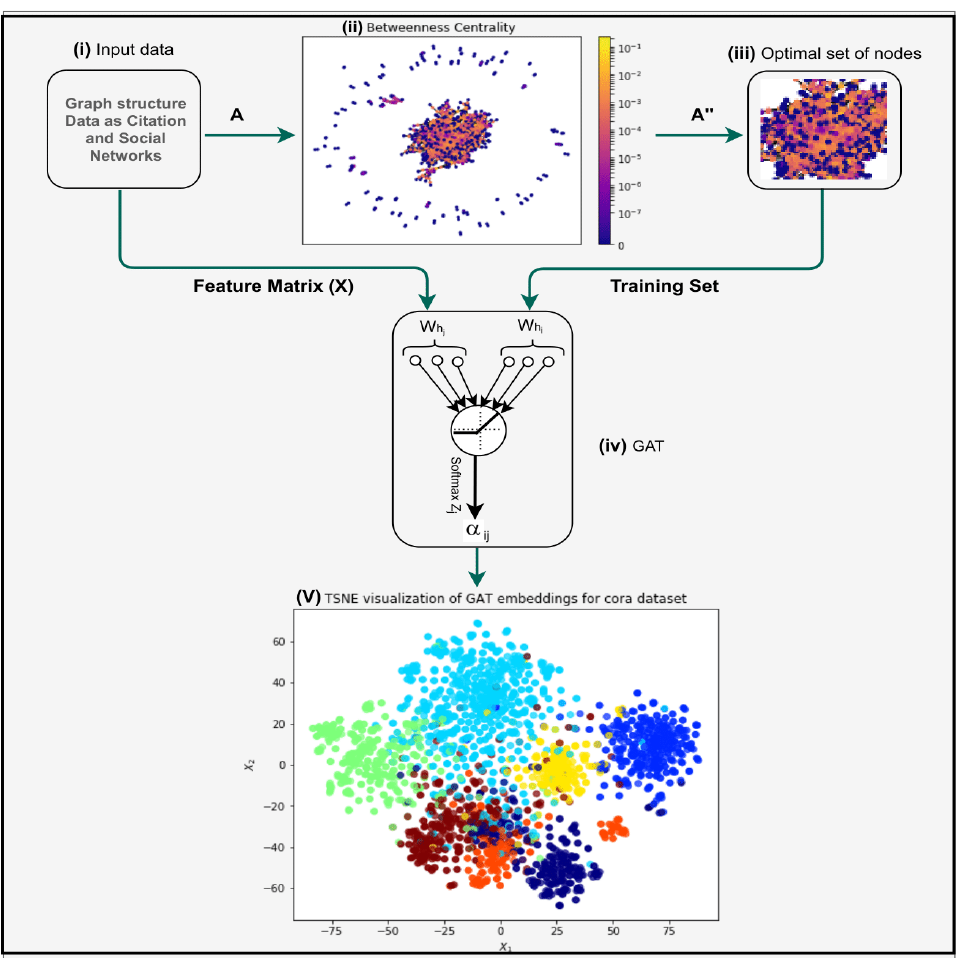
Figure 5. Diagrammatic representation of node sampling based on betweenness